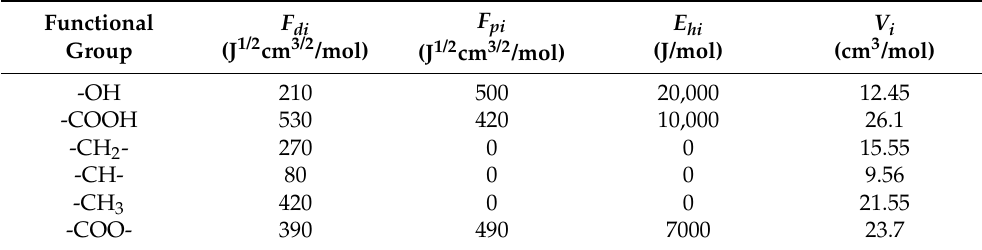
Table A2. The dispersion components F di , and the polar components F pi of the molar attraction constant as well as the hydrogen bonding energies E literature